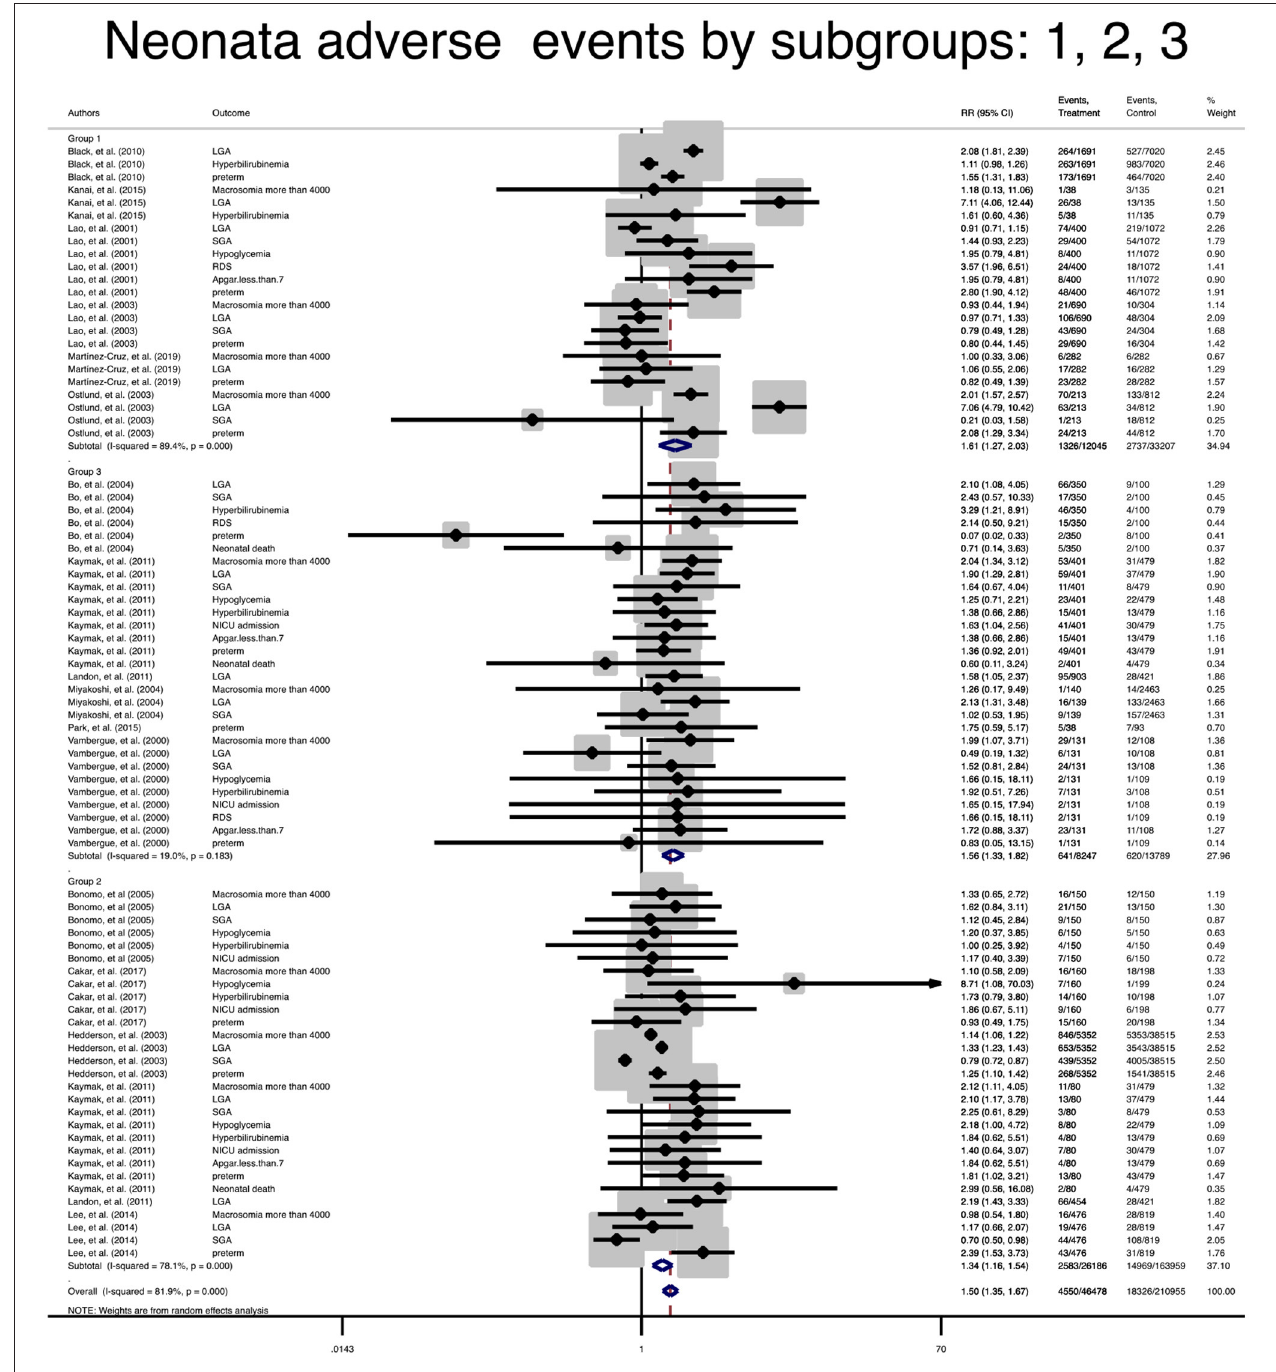
FIGURE 5 | Forest plot of pooled relative risk of adverse neonatal events in subgroups.